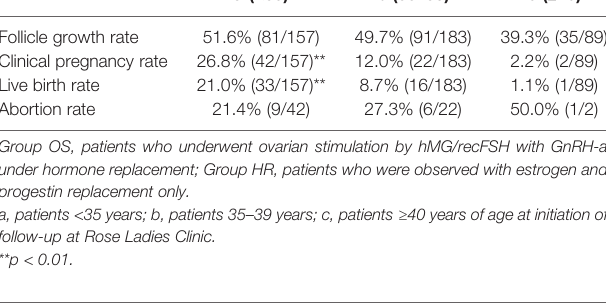
TABLE 3 | Clinical pregnancy and live birth rates in cycles in which either IVF or TABLE 4 | Clinical pregnancy and live birth rates per case in patients in Group IUI/TI was attempted in patients in Group OS. IVF cycle Clinical pregnancy rate